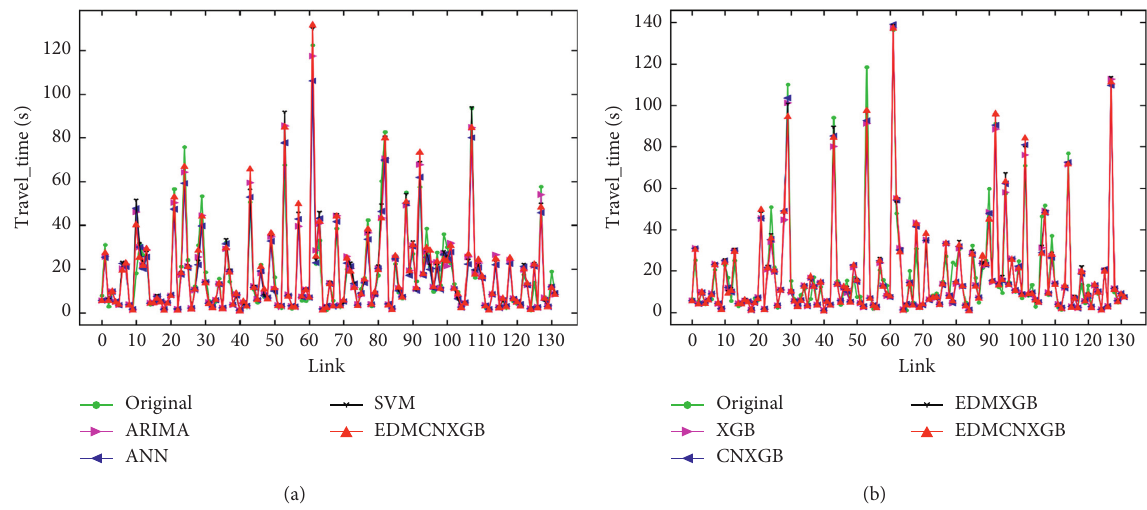
Figure 10: The actual operation status of the road network at a specific moment and the predicted values of different models. (a) Longitudinal comparison of predictive models. (b) Horizontal comparison of predictive